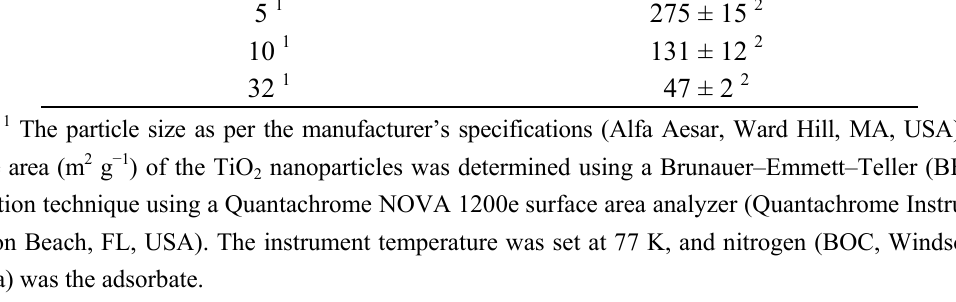
Table 1. The TiO